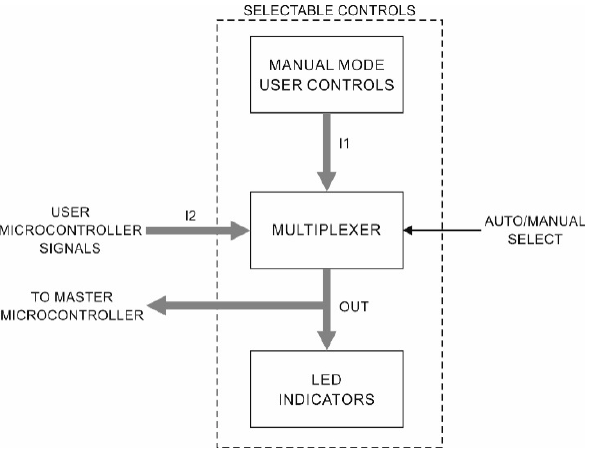
Figure 3. Selectable controls of the Rail-Network Simulator.